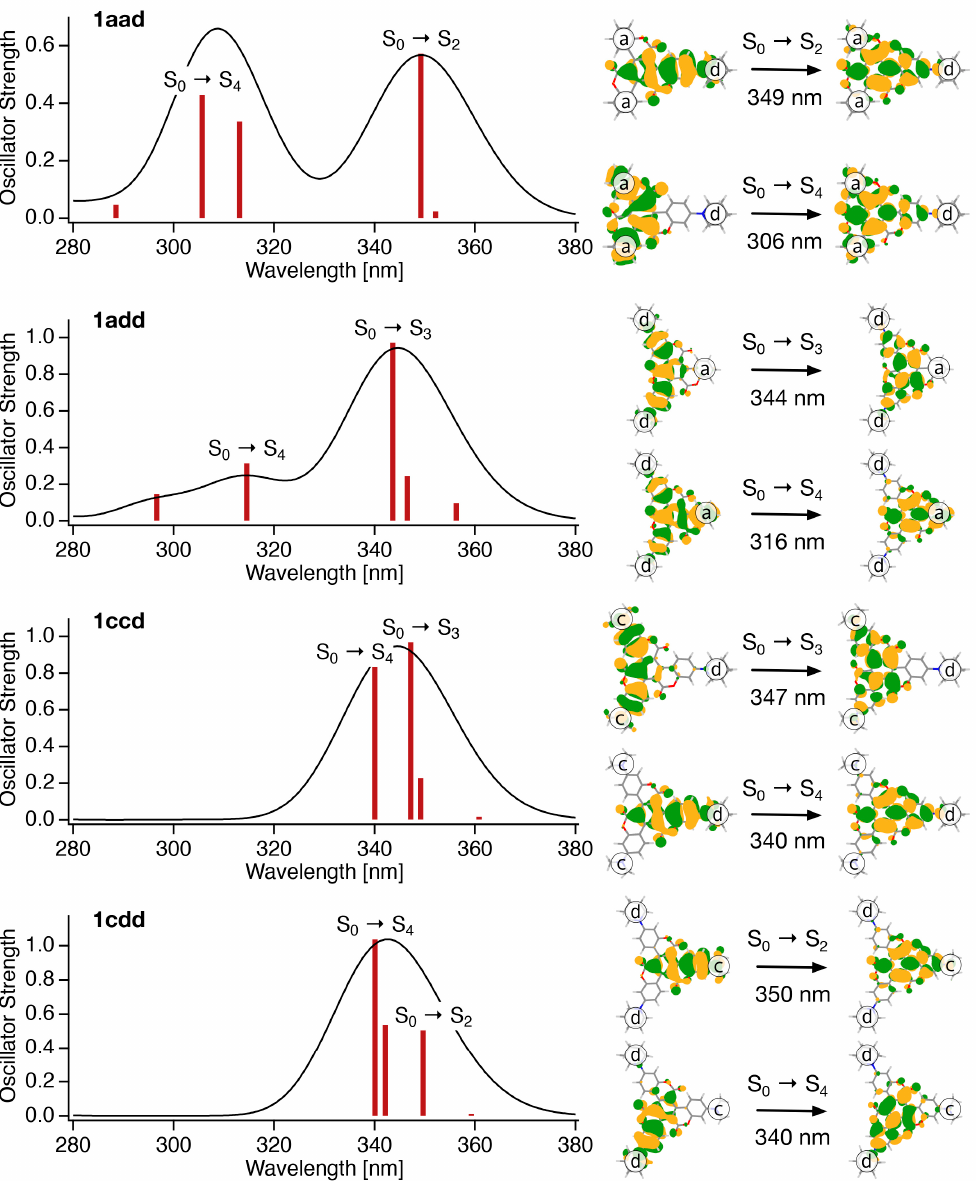
Figure 6. Absorption spectra simulated by quantum chemical calculations, and the main components of the natural transition orbitals (NTOs) for each electronic excitation. Absorption spectra were simulated by the Gaussian ‐ shaped bands’ half ‐ width at half maximum of 1000 cm − 1 .